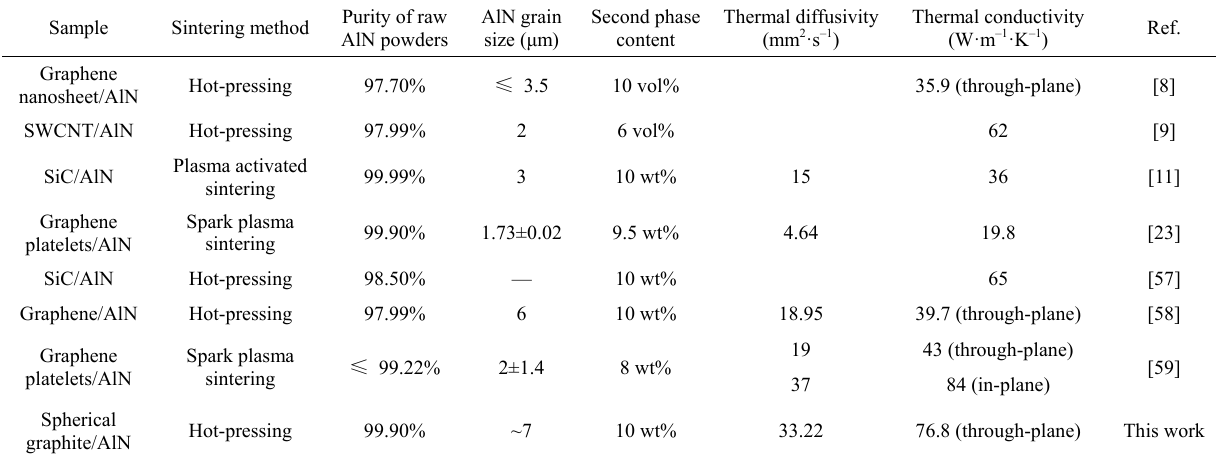
Table 1 Thermal properties of AlN-based composites with different second